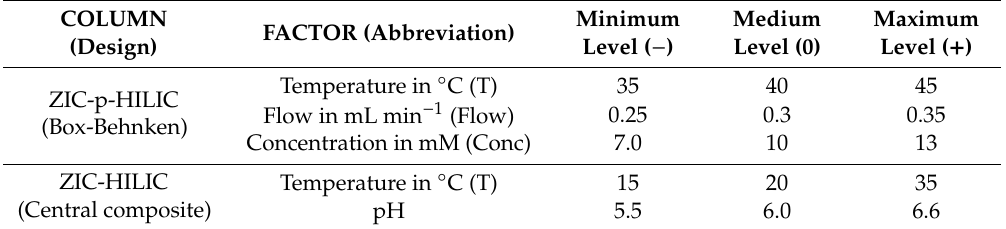
Table 2. Detailed description of the Box-Behnken design and central composite design for ZIC-p-HILIC and ZIC-HILIC columns.